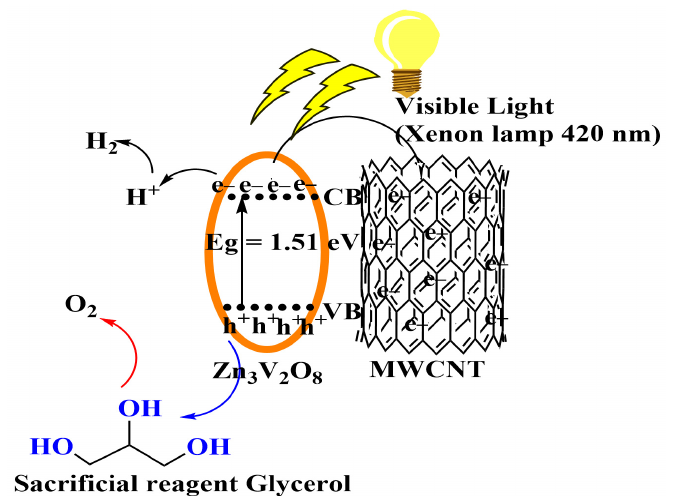
Figure 11. ( a ) Reusability plot for ZV@MWCNT towards PC H 2 production and ( b ) corresponding XRD spectra of the material before and after five cycles of application.